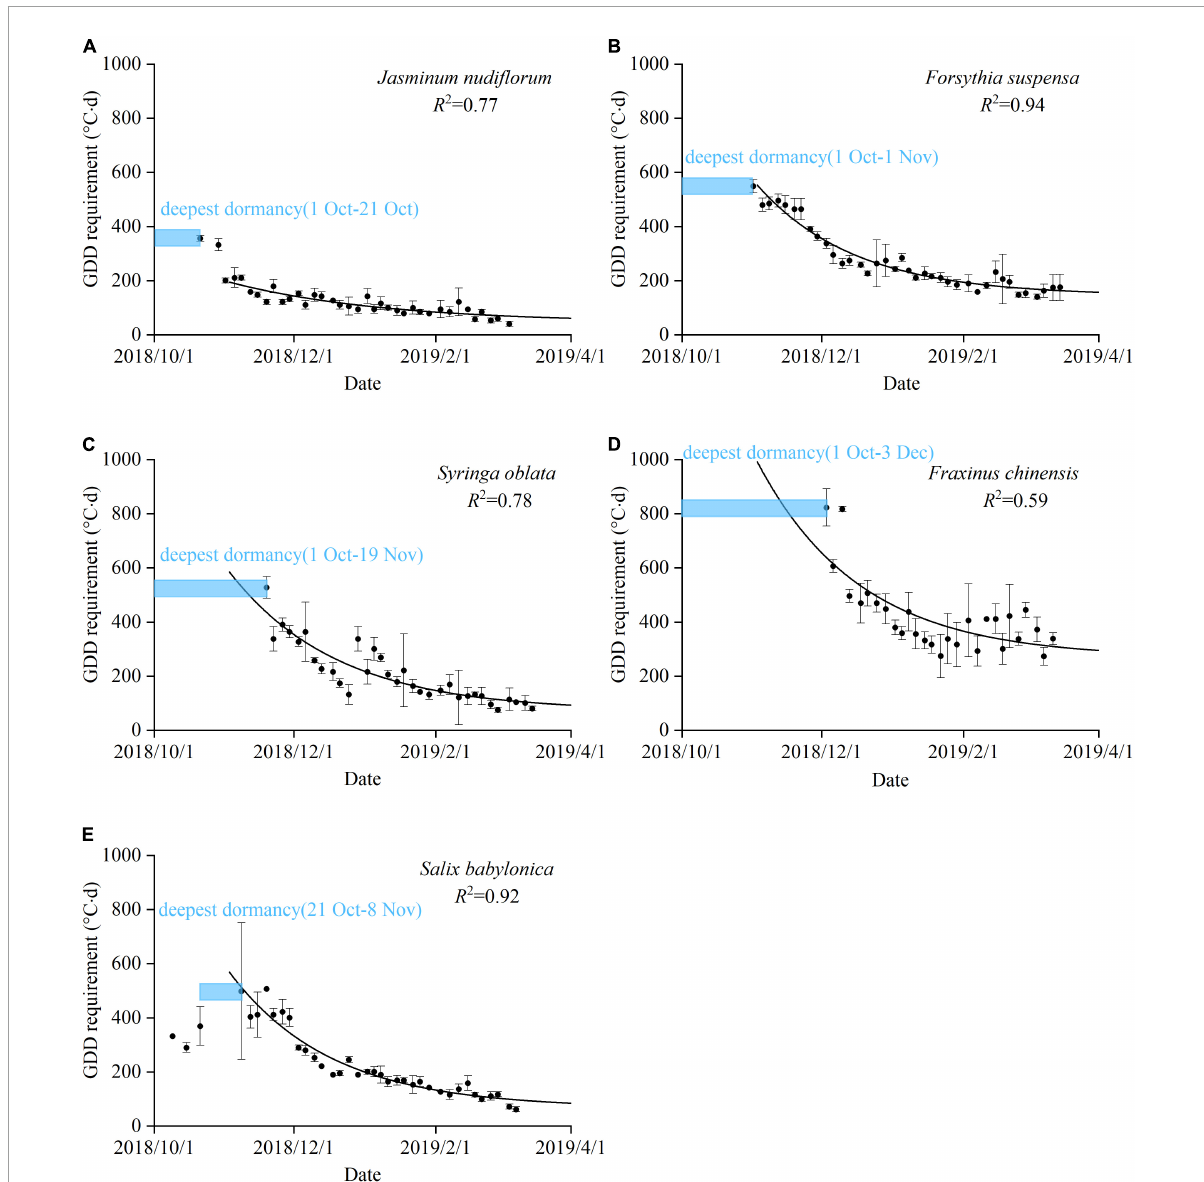
FIGURE2 Seasonal variation in dormancy depth for five species. A blue box indicates the period of maximum dormancy depth, i.e., budburst did not occur even with sufficient growing degree days (GDD = 871 ◦ C · days, equivalent to the GDD from January to May in Beijing). Black dots: the GDD requirement (GDD R ) of plants observed in the experiment. Error bars: standard deviation of five twigs. R 2 : coefficient of determination for the exponential function. (A) J. nudiflorum , (B) F. suspensa , (C) S. oblata , (D) F. chinensis , and (E) S. babylonica